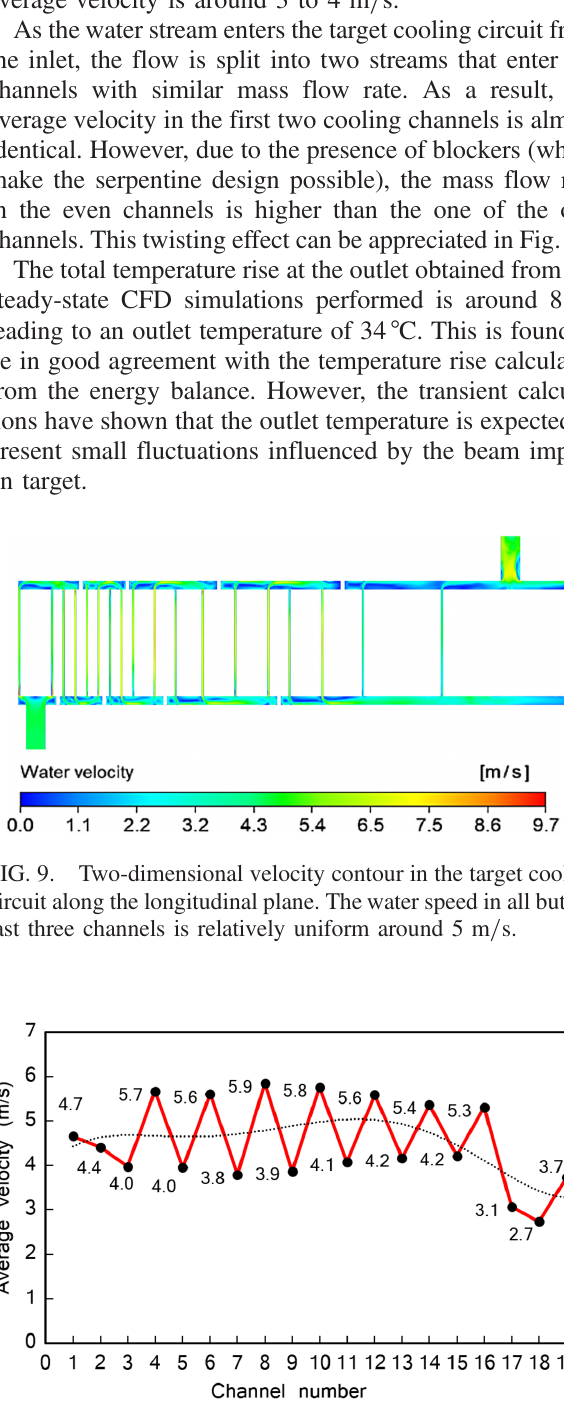
FIG. 10. Variation of average velocities in the target water channels. The trendline of the plotted values is represented by a dotted line, and stands close to the desired water velocity of 5 m = s.